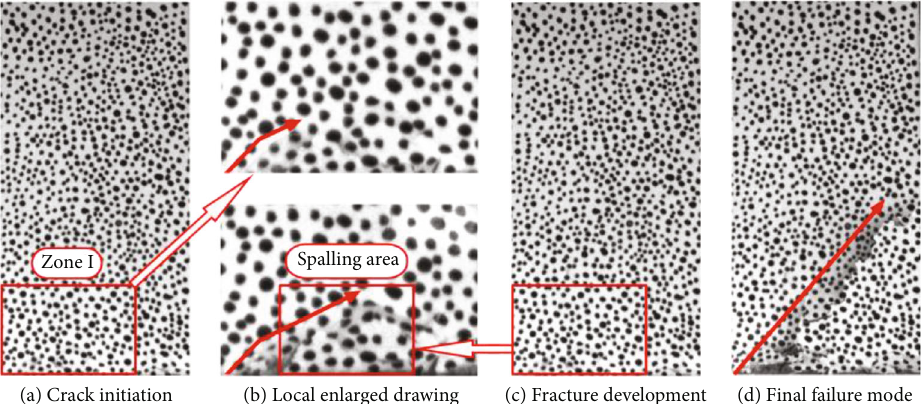
Figure 7: The surface fracture evolution process of specimen